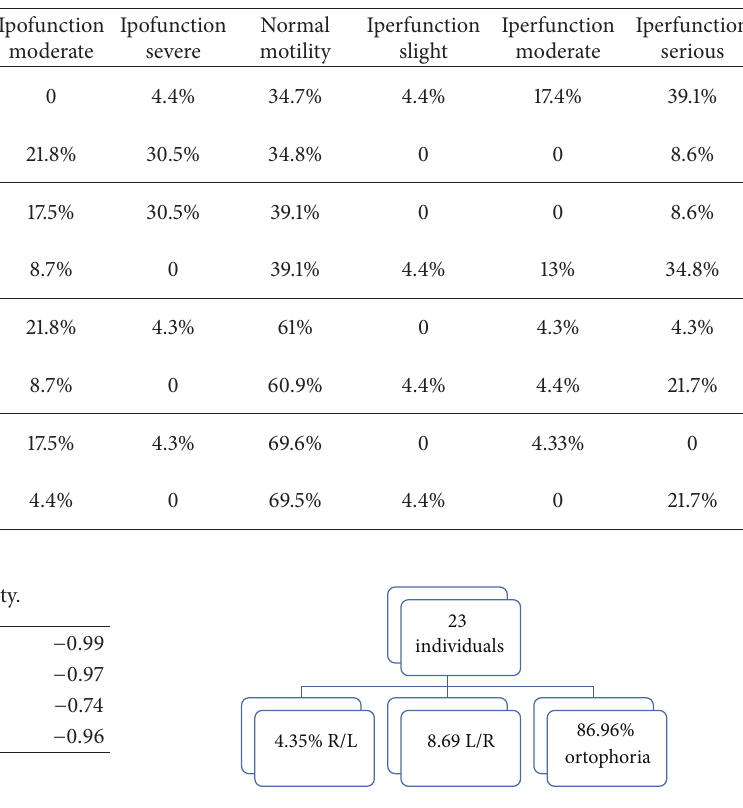
Figure 3: Cover test: evaluation of vertical deviation for near (with or without corrective